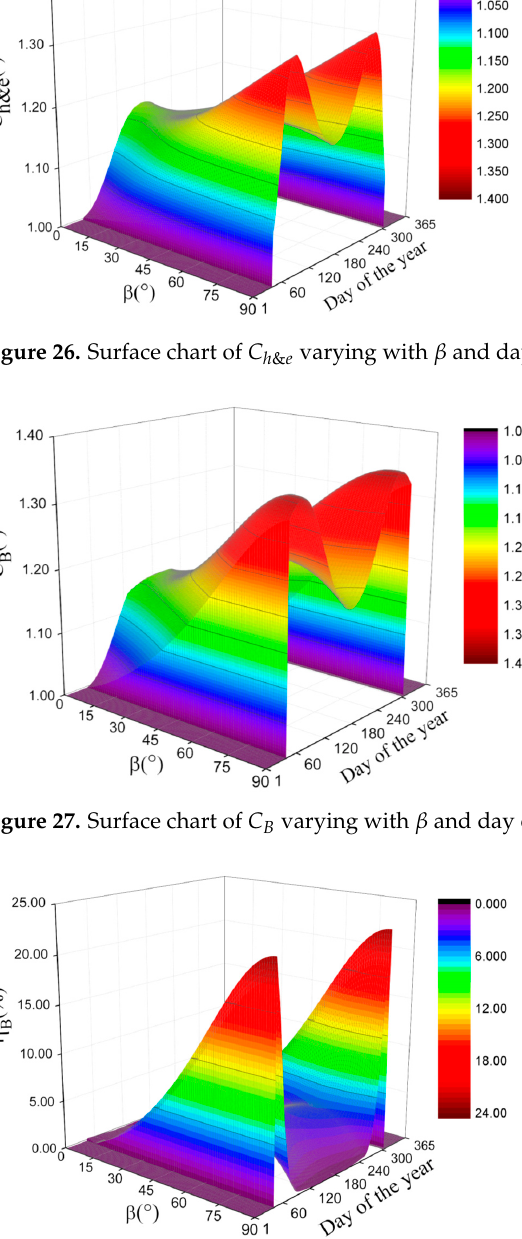
Figure 28. Surface chart of 𝜂 (cid:3003) varying with 𝛽 and day of the year at 75° N and 𝜌 = 0.2 . As shown as in Figures 26 and 27, the correction factors are equal to 1.0 both for 𝐶 (cid:3035)&(cid:3032) and 𝐶 (cid:3003) during the period of the polar nights. In non-polar night situations, the peaks of the surface charts of 𝐶 (cid:3035)&(cid:3032) , 𝐶 (cid:3003) , and 𝜂 (cid:3003) appear in the ranges of a larger 𝛽 and the first or the final days of the year, which are shown in Figures 26–28. As shown in Figure 28, the two maxima of 𝜂 (cid:3003) are 22.97% and 22.70% while 𝛽 is 90° and the days of the year are 41 and 303 respectively, but it must be mentioned that 𝐶 (cid:3003) and 𝜂 (cid:3003) cannot be calculated in